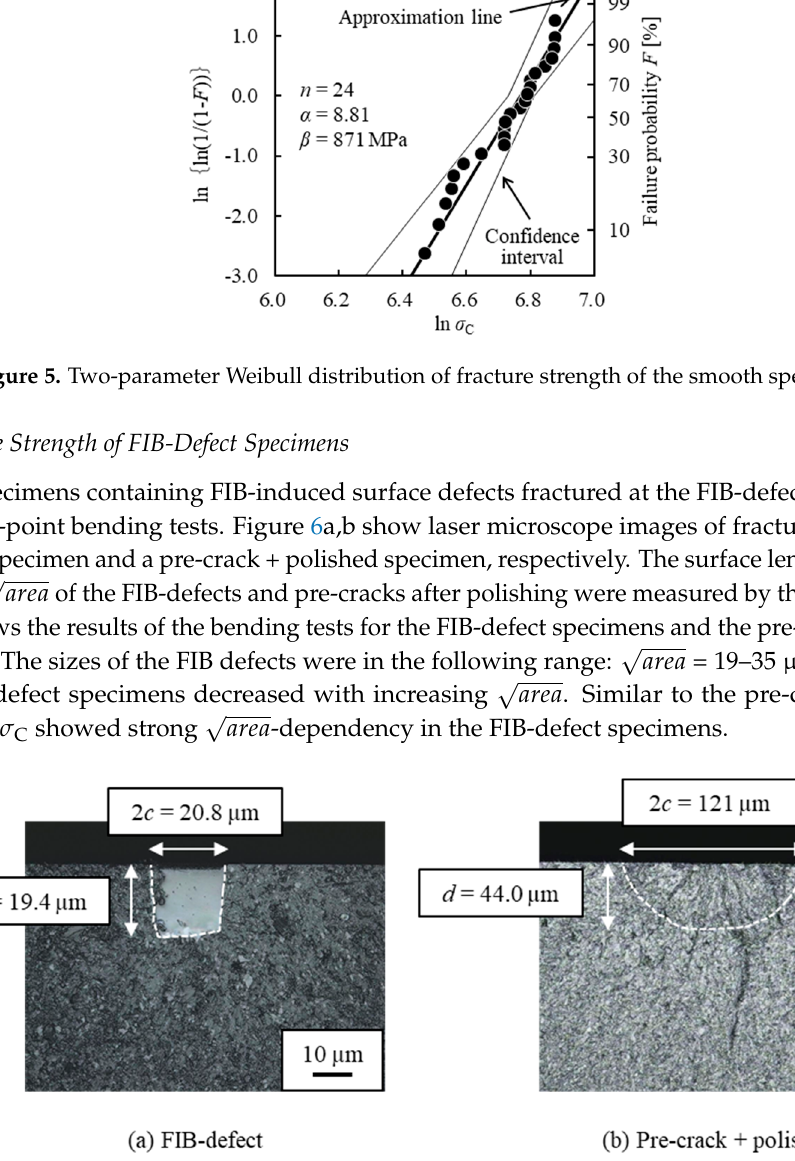
Figure 6. Laser microscope images of fracture surfaces: ( a ) FIB-defect specimen, √(cid:1853)(cid:1870)(cid:1857)(cid:1853) = 19.1 µm, σ C = 687 MPa; ( b ) pre-crack + polished specimen, √(cid:1853)(cid:1870)(cid:1857)(cid:1853) = 64.6 µm, σ C = 400 MPa. Table 2. Bending test results.